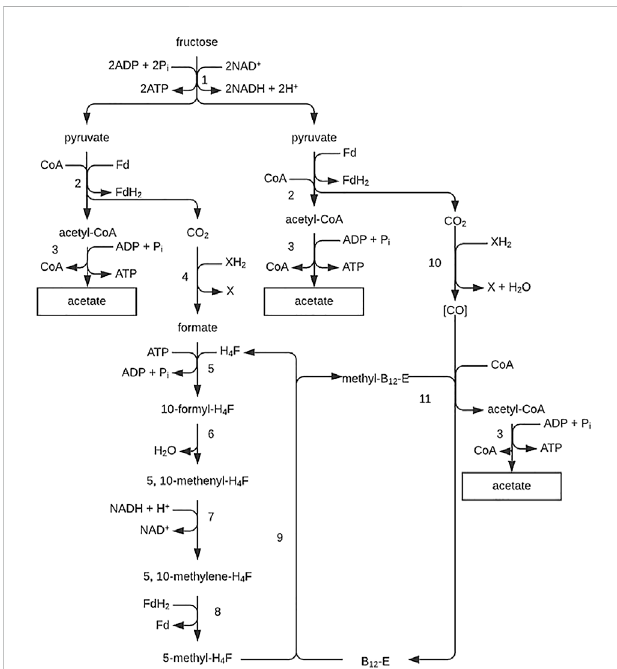
FIGURE 10 Pathway of the acetate fermentation. Figure redrawn after reference(Gottschalk,1986).1,Degradationoffructose via theEmbden- Meyerhof-Parnas pathway; 2, pyruvate-ferredoxin oxidoreductase; 3, phosphotransacetylase plus acetate kinase; 4, formate dehydrogenase; 5, formyl-tetrahydrofolate synthetase; 6, methenyl- tetrahydrofolate cyclohydrolase; 7, methylene-tetrahydrofolate dehydrogenase; 8, methylene-tetrahydrofolate reductase; 9, tetrahydrofolate: B 12 methyltransferase; 10, CO dehydrogenase; 11, acetyl-CoA-synthesizing enzyme (probably ATP-requiring); (CO),